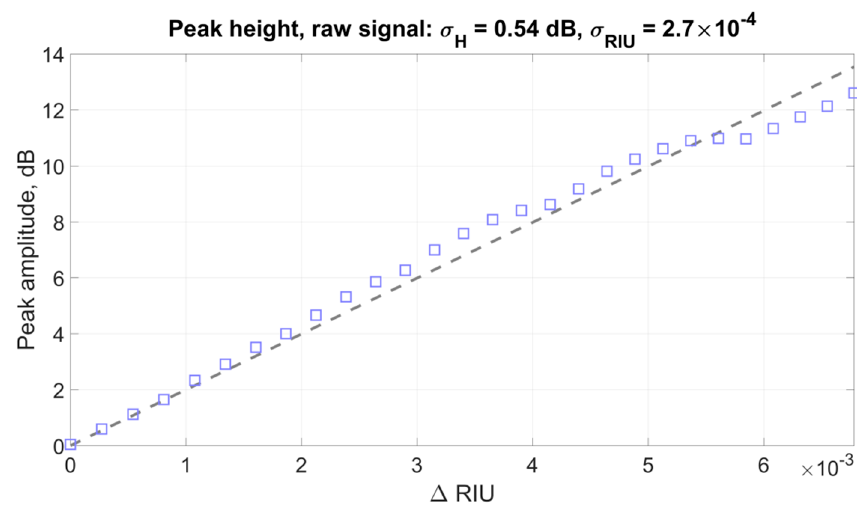
Figure 15. Dependence of the peak height in the region of 1541 nm on the change in the refractive index and the straight approximating line for the “classical” method applied to the original signal.